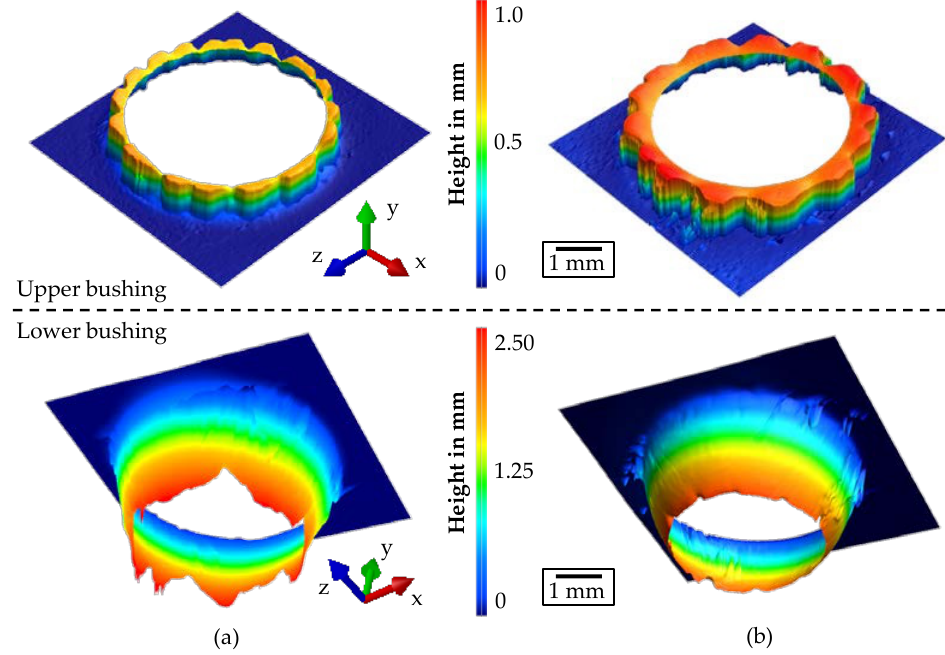
Figure 8. Optically measured 3D profiles of the upper and lower bushings for HX220 at a 1.2 mm sheet thickness ( a ) and HX420 at 1.5 mm ( b ).